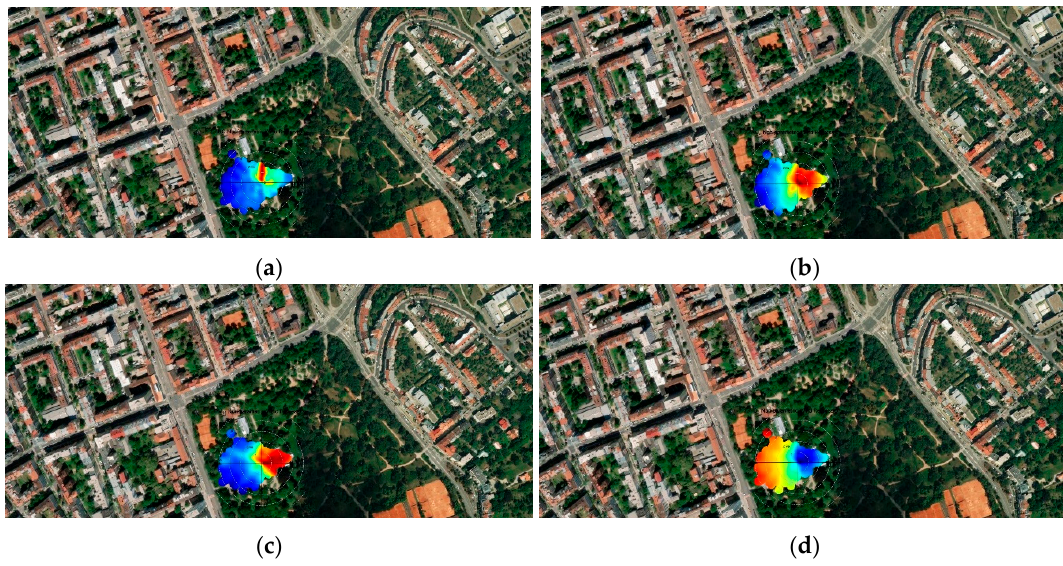
Figure 13. The NO ( a ), NO 2 ( b ), PM 10 ( c ), and O 3 ( d ) concentration relationships to the wind speed and direction at Lužánky SVC; sampling started on 6.3.2019 7:00.